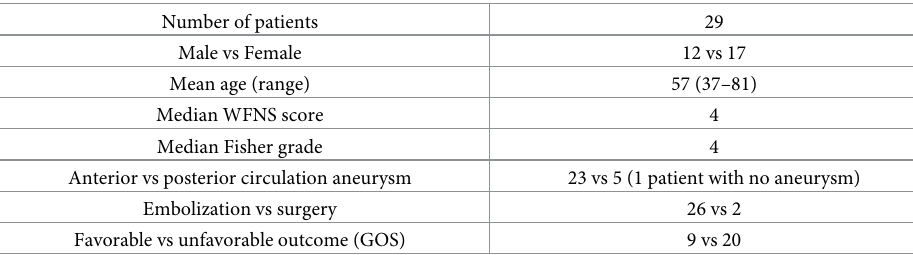
Table 1. Demographic data of the patient